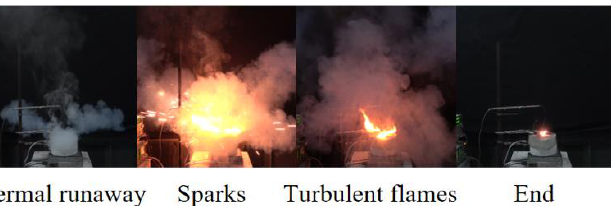
Figure 7. Typical thermal runaway behaviors under different discharge conditions in Group ⅲ .